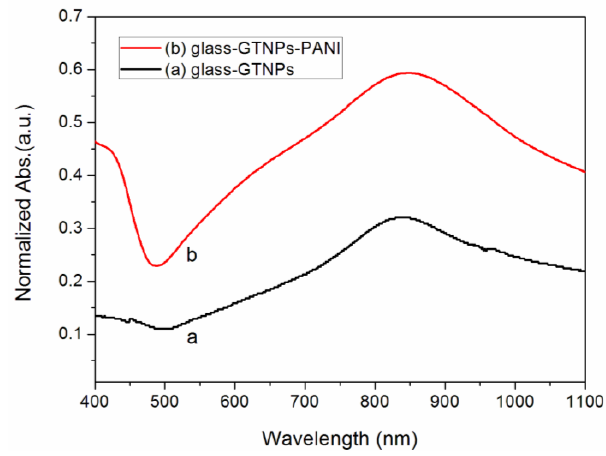
Figure 4. Visible-near-infrared (Visible-NIR) spectra of GNPs ( curve a ) and PANI-GNPs ( curve b ) on glass in water (pH = 6.5).